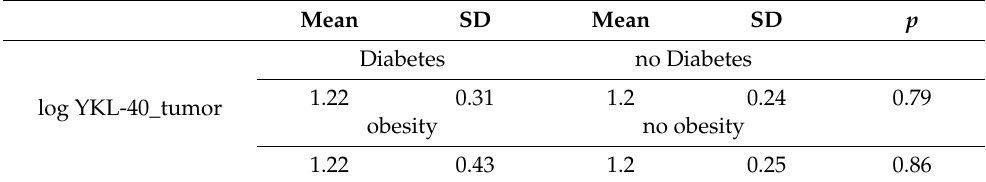
Table 4. Correlations between the YKL-40 levels and the examined molecules. R—Pearson’s correla- tion coefficient. Mean SD Mean